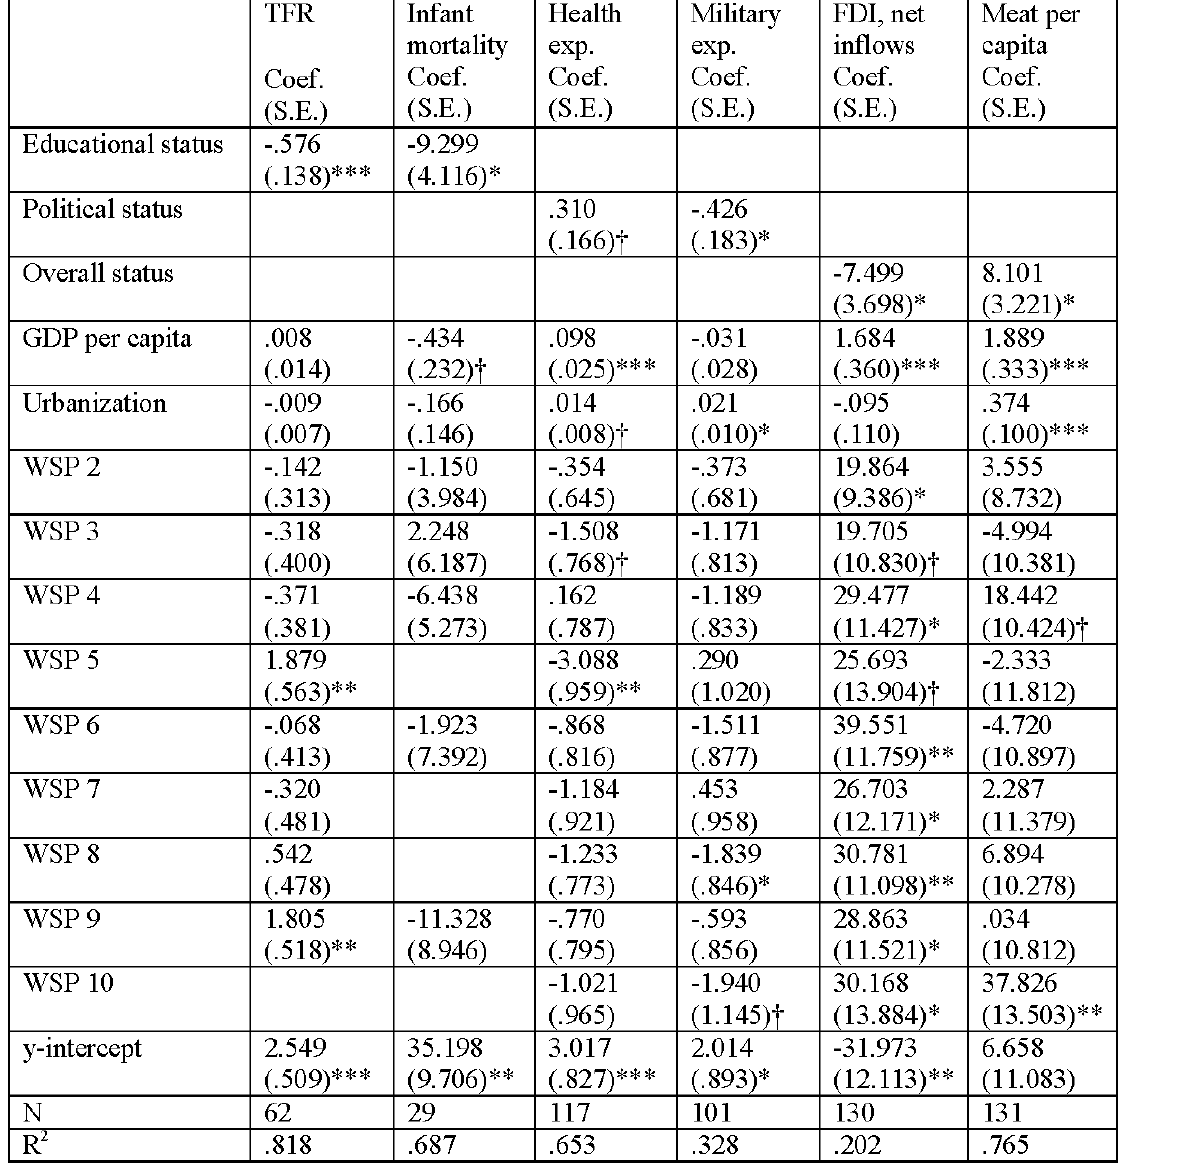
Table 4. Total Fertility Rate (TFR), Infant Mortality Rate, Government Expenditures on Health Care, Military Expenditures, Net Inflows of Foreign Direct Investment (FDI), and Meat Consumption per capita Regressed on Women's Status (educational, political, or overall), GDP per capita, Urbanization, and World-System Position (ten blocks). Infant Health Military FDI, net Meat per mortality exp. exp. inflows